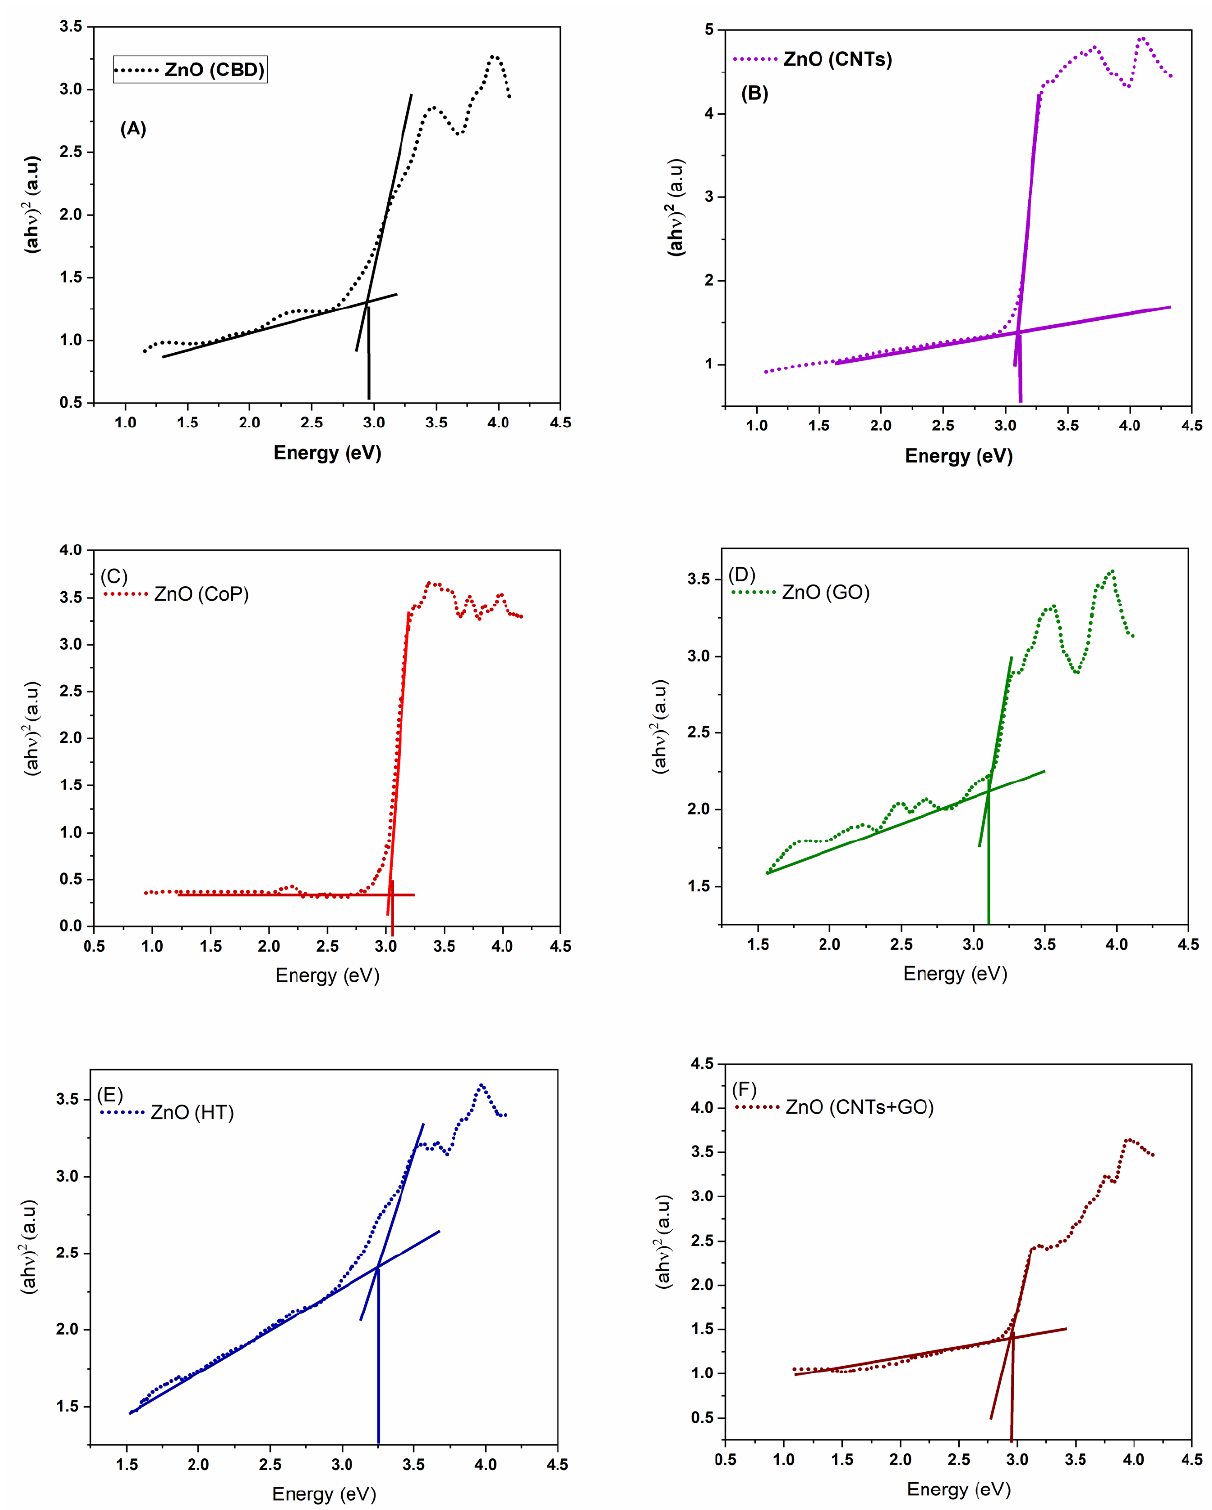
Figure 5. Tauc plots for band gap calculation of ZnO (( A )—CBD, ( B )—CNTs, ( C )—CoPs, ( D )—GO, ( E )—HT, and ( F )—CNTs + GO) nanostructures and